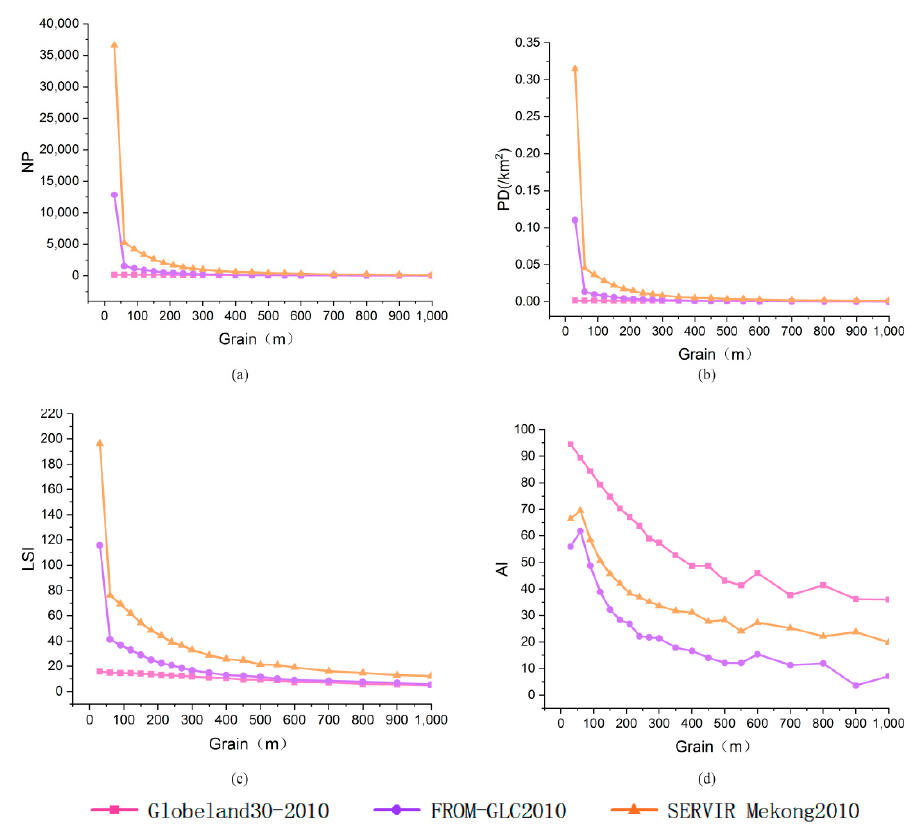
Figure 8. The artificial surface landscape indices changing curves with scale increasing. ( a ) is the NP curve; ( b ) is the PD curve; ( c ) is the LSI curve; ( d ) is the AI curve.